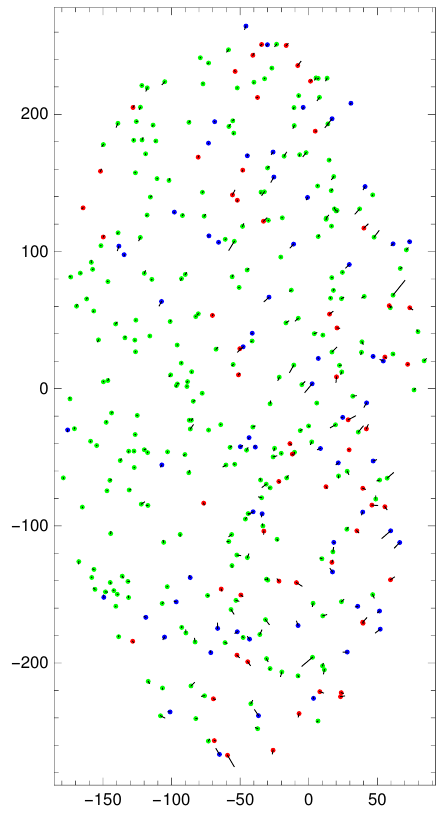
Figure 6. Positions of 380 simulations with Q = 10 5 µmolmol − 1 m 3 s − 1 measured at a height of z 0 = 10m, with the true positions sampled uniformly from the pale blue ellipse in Fig. 1 with the x , y positions given there. The reconstructed position is shown with a dot. Each line segment runs from the reconstructed position to the true position. (Many of these line segments are very short and appear as small black dots.) The blue dots represent the lowest one-sixth predicted leak rates, and the red dots represent the highest one-sixth predicted leak rates. The green dots represent the middle